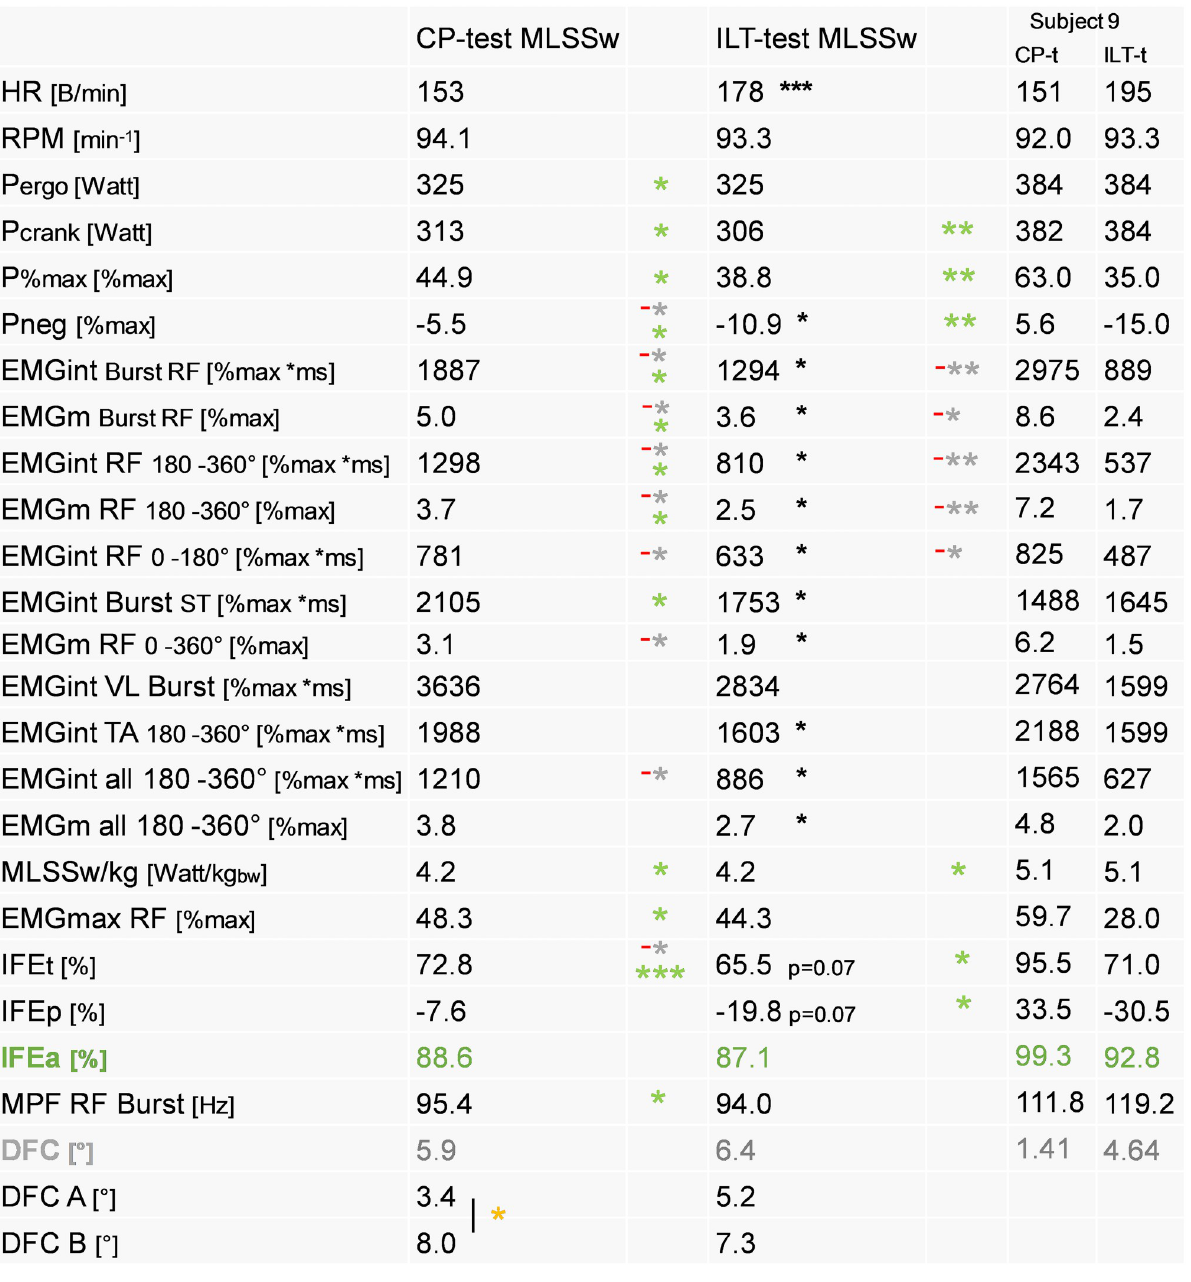
PLOS ONE | https://doi.org/10.1371/journal.pone.0282391 March 16,